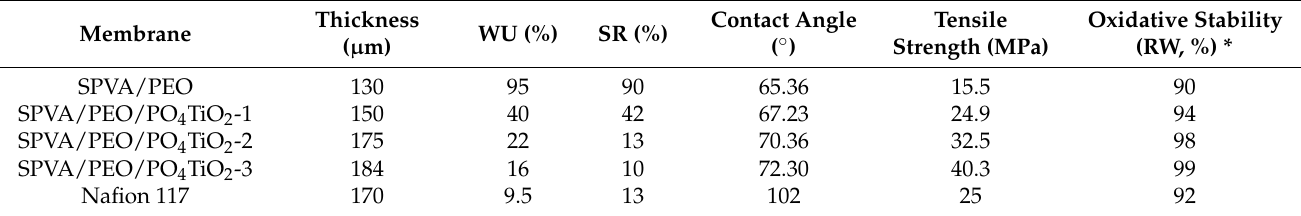
Table 1. Physicochemical parameters of the formulated composite membranes compare to Nafion 117 [1,24]. Thickness Membrane SPVA/PEO 130 SPVA/PEO/PO 4 TiO 2 -1 SPVA/PEO/PO 4 TiO 2 -2 175 SPVA/PEO/PO 4 TiO 2 -3 184 Nafion 117 * The retained weight of membranes (RW) after immersion for a day in Fenton’s